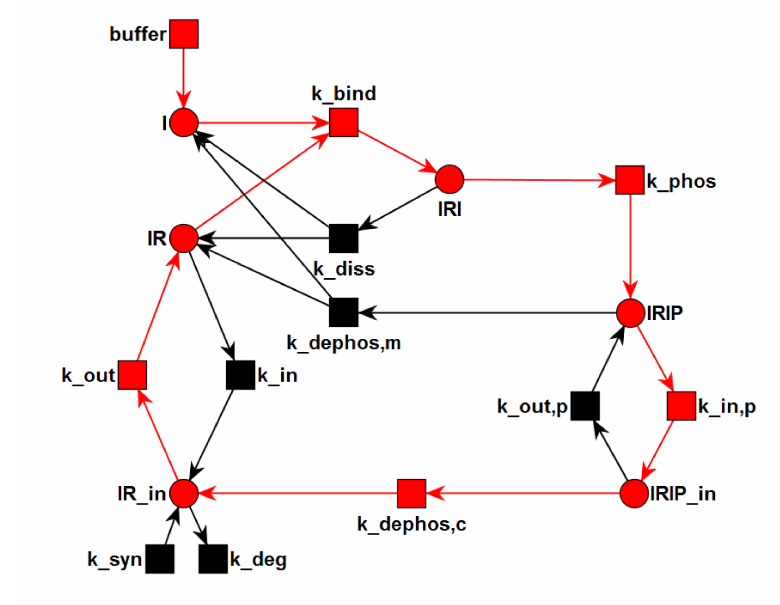
Figure 5. The transition invariant, TI , is highlighted in the PN. The six transitions of 2 TI form a chain of six consecutive reactions: buffering of insulin ( buffer ), binding of 2 insulin to the IR ( k ), phosphorylation of the insulin-IR complex ( k bind of the activated insulin-IR complex ( k ), dephosphorylation of the internalized insulin-IR in,p complex ( k ), and translocation of internalized IR back to the membrane ( k dephos,c